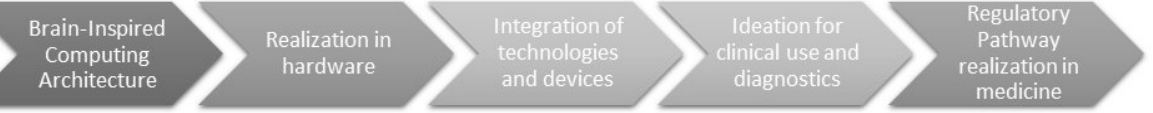
Figure 1. Considerations for the pathway of the realization of brain-inspired computing in medicine.